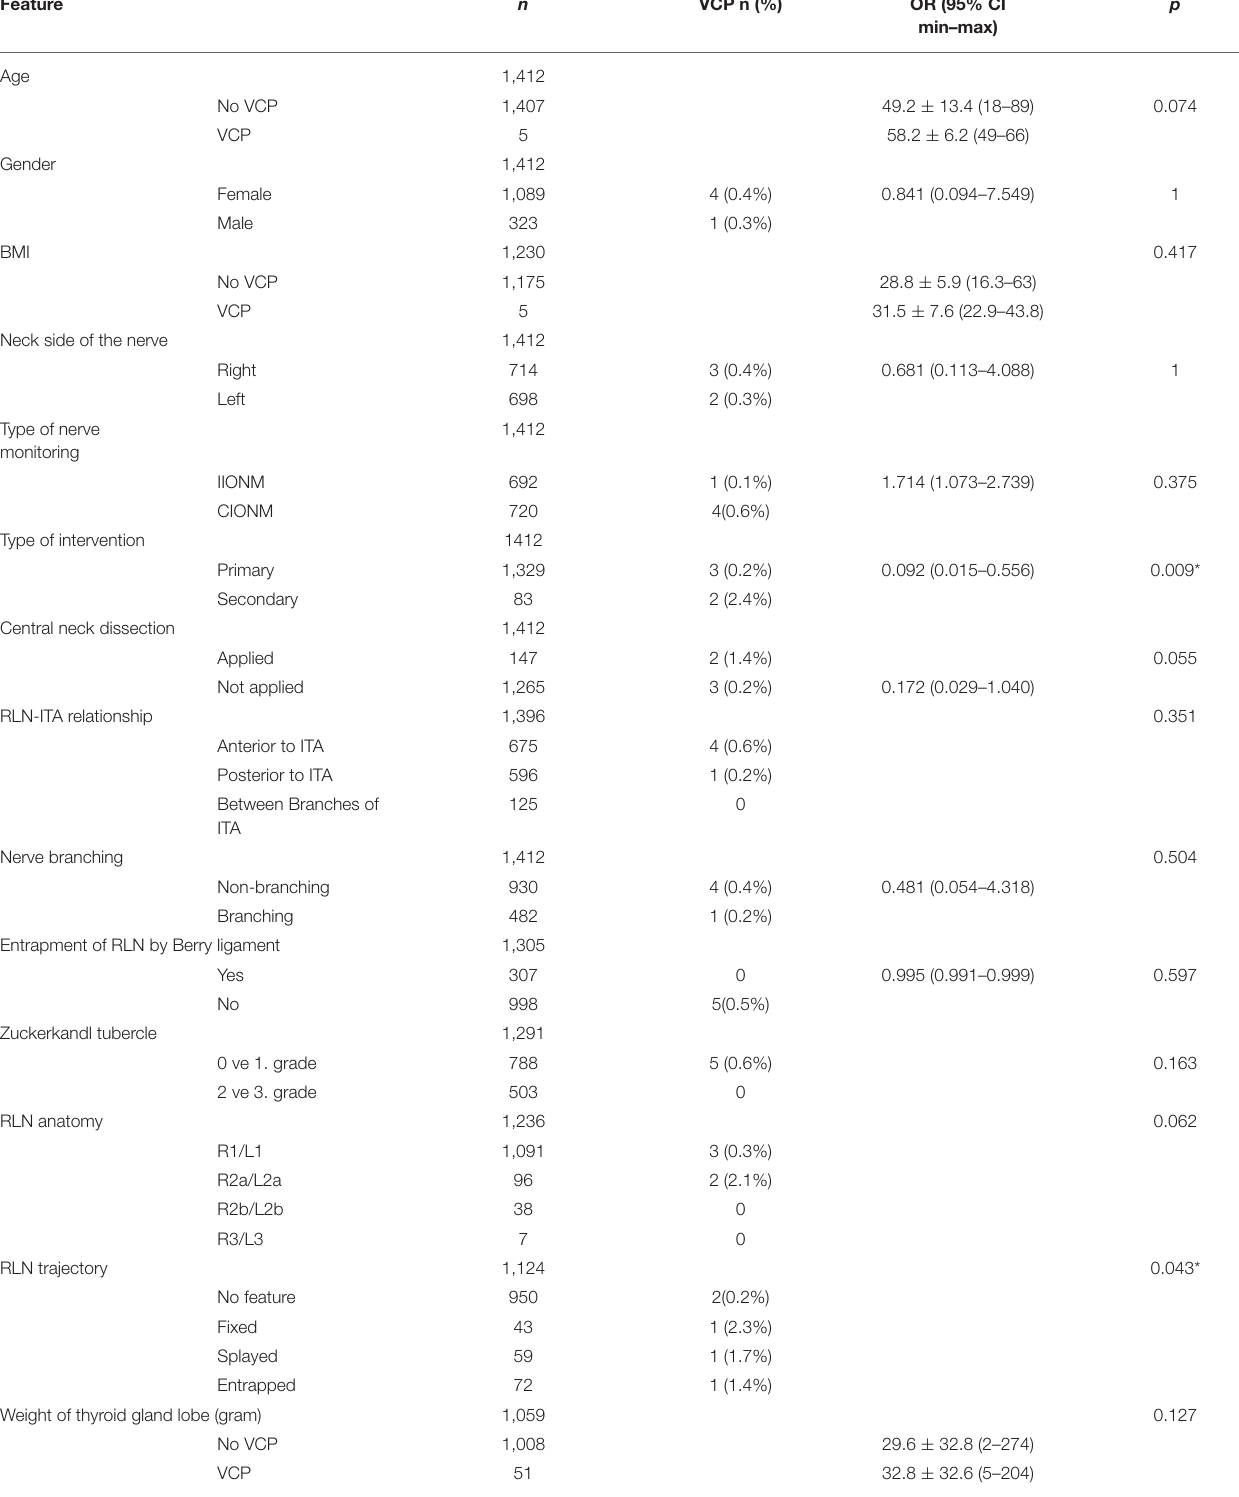
TABLE 3 | Evaluation of clinical and anatomical factors for permanent VCP by univariant